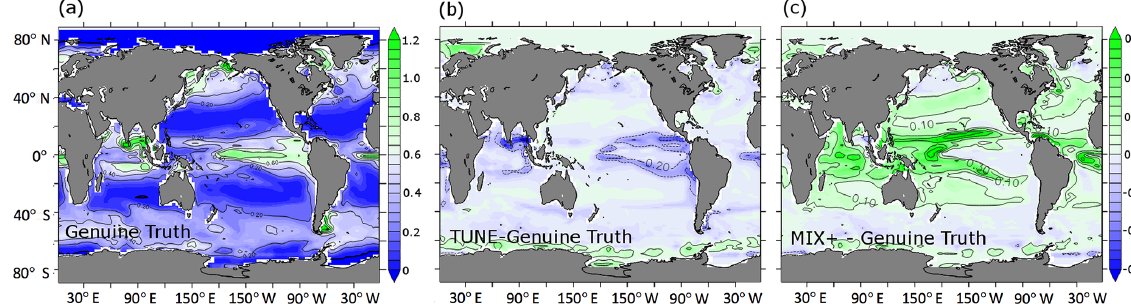
Figure 5. Simulated phytoplankton concentrations in millimoles of nitrogen per cubic meter (mmolNm − 3 ) for the historical simulations (see Sect. 2.2.2). Panel (a) refers to results from the model configuration Genuine Truth. Panels (b) and (c) show the difference between the results from the model configurations TUNE and MIX+ and the Genuine Truth, respectively. MIX+ and TUNE feature increased vertical